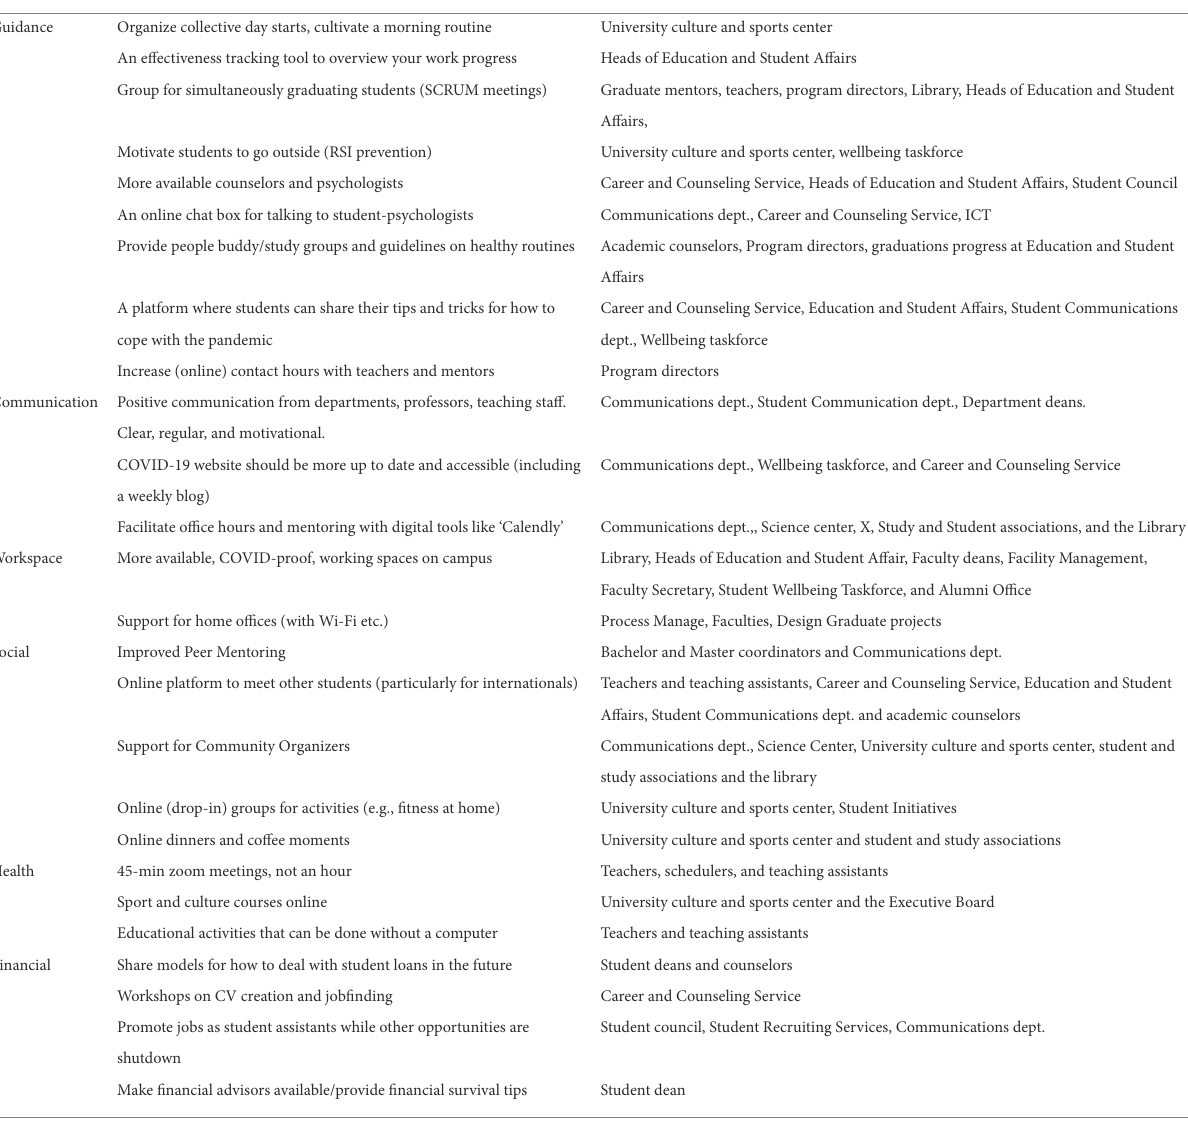
TABLE 4 Many examples of ideas for action coupled with a potential actor (i.e., ‘a cybernetic processor’) and their respective areas of need as communicated back to the community.